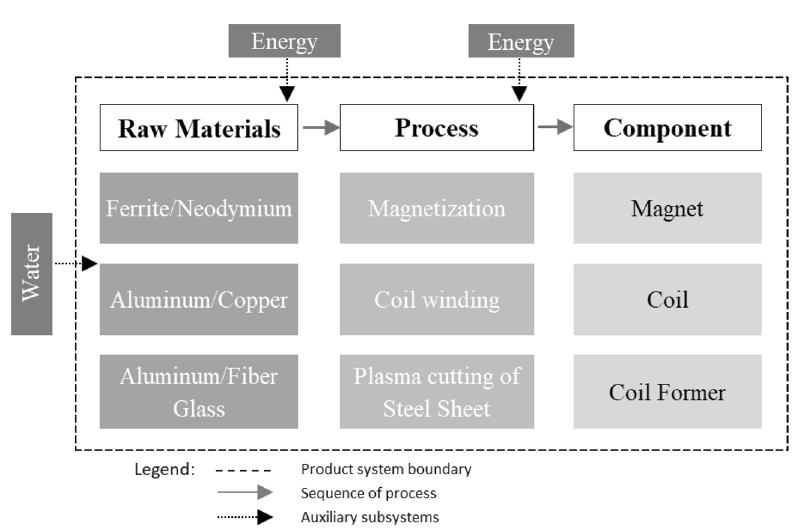
Figure 2. Grayscale diagram with three columns/steps with arrows signaling the inputs and outputs of the flow of materials, components, and processes in the production of a conventional